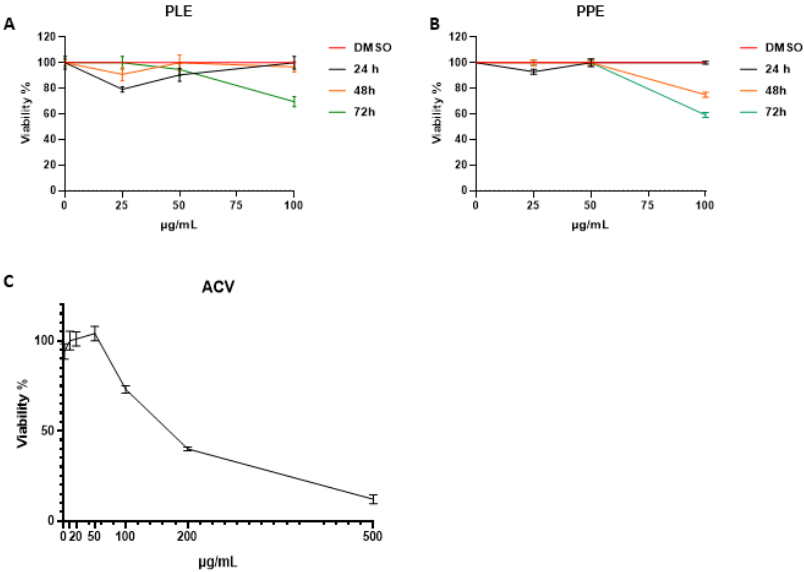
Figure 4. Viability assay in Vero cells treated with P. granatum ethanolic extracts (PLE and PPE). ( A , B ) Vero cells were treated with different concentrations of pomegranate extracts (25 µg/mL, 50 µg/mL and 100 µg/mL). The cells were collected 24, 48 and 72 h post-treatment. The cell viability